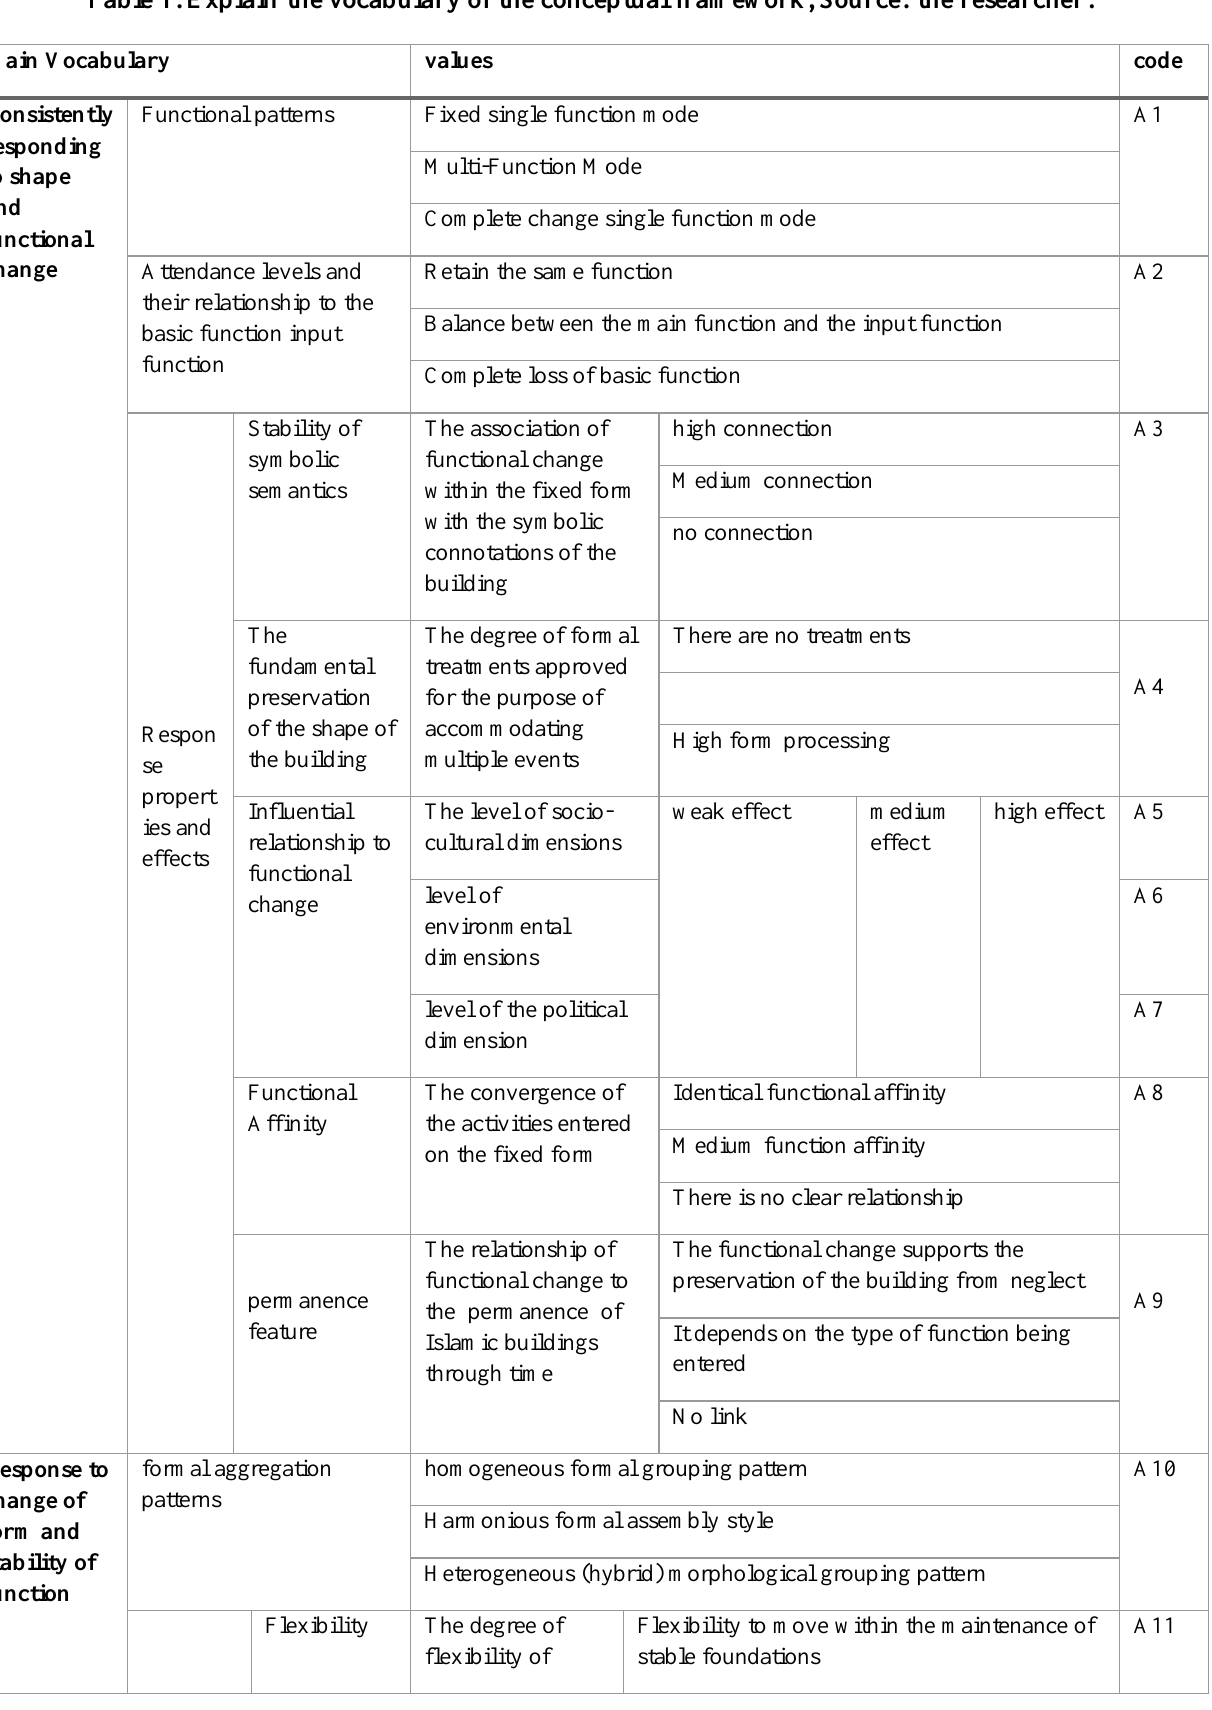
Table 1. Explain the vocabulary of the conceptual framework, Source: the researcher. Main Vocabulary values code Consistently responding to shape